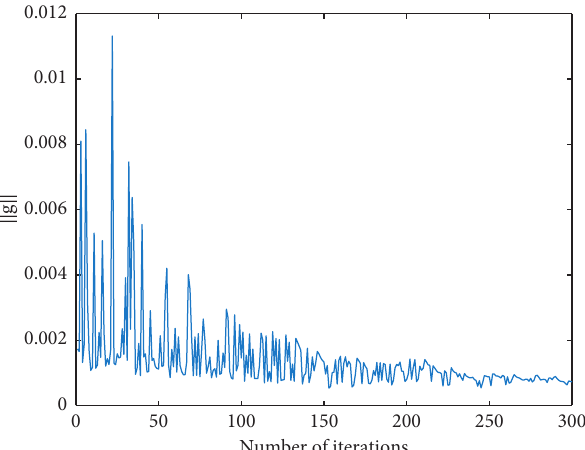
Figure 3: Convergence behavior of AdaMax algorithm for the first 300 of 7208 iteration